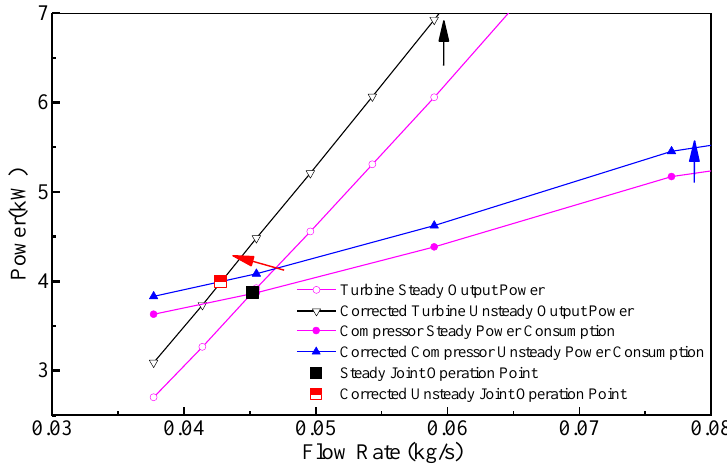
Figure 11. Joint point correction of the original turbocharger at 150,000 rpm.